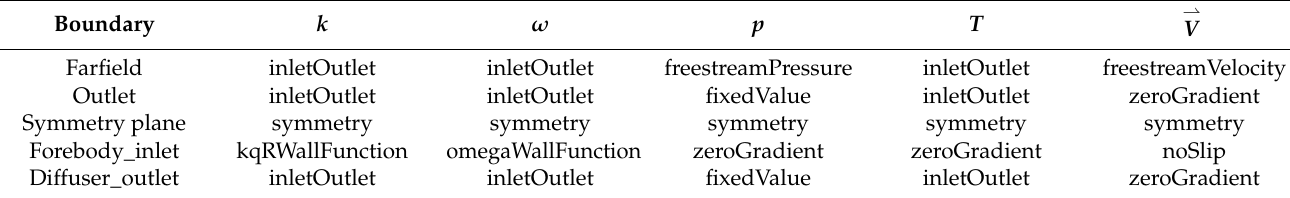
Table 2. Boundary condition settings for the computational domain.